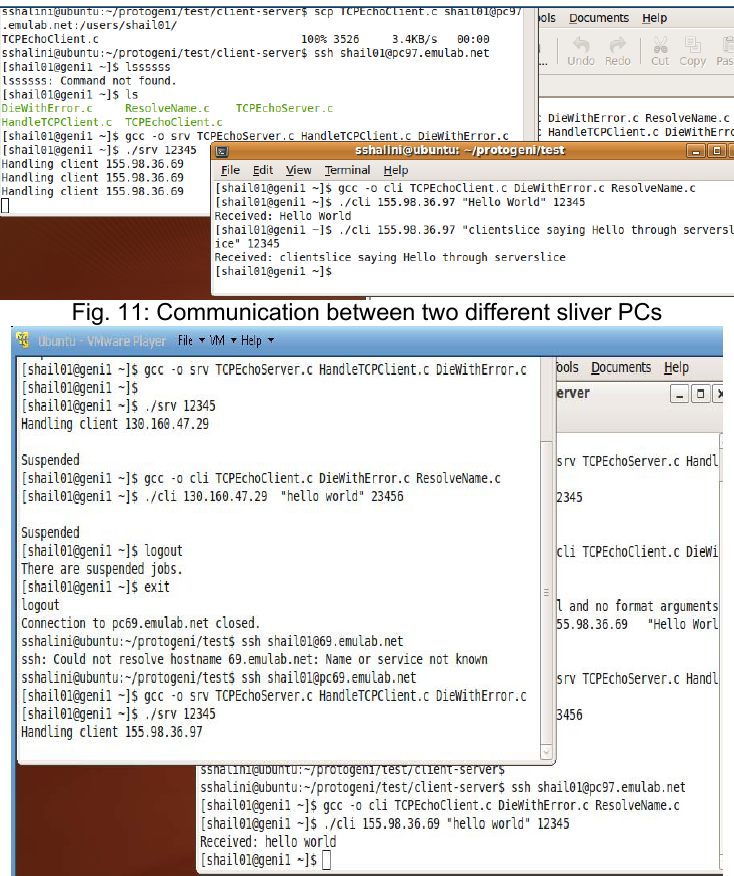
Fig. 11: Communication between two different sliver